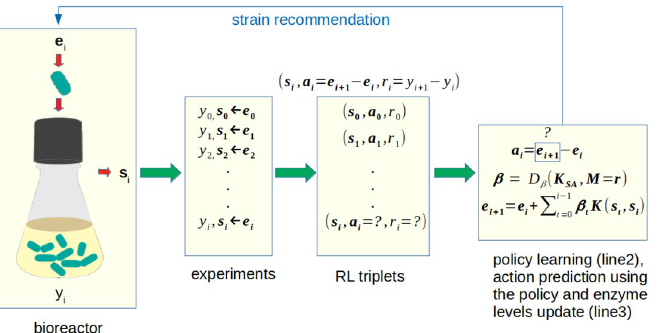
Fig 1. Strain design optimization loop using reinforcement learning. Enzyme levels corresponding to the strain i are denoted as e , and y and s , correspond to the response (used in reward) and output concentrations (used as state), i i i respectively. The action ( a i ), corresponding to the difference of the enzyme levels in the two consecutive iterations, is given by the policy learned with MMR.